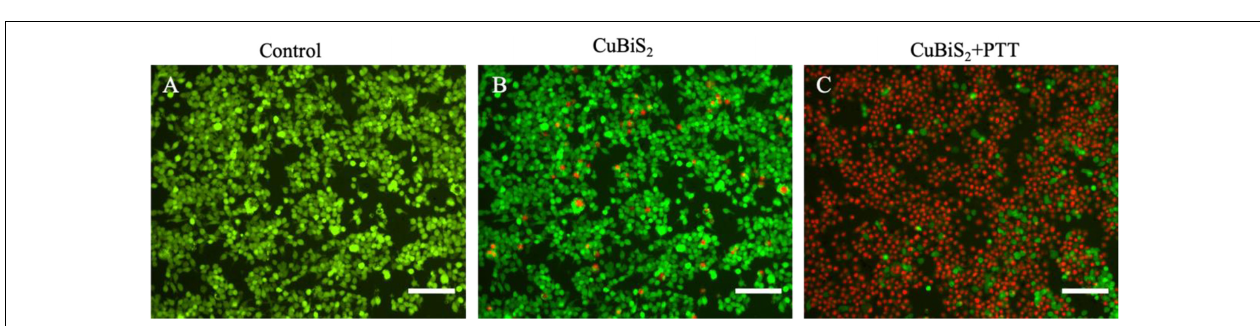
FIGURE 4 | Photothermal effect of CuBiS 2 NPs on macrophages by Calcein AM/PI and flow cytometry. (A–C) Representative images of live (green) or dead (red) cells without or with CuBiS 2 NPs co-incubation (160 mg/mL), respectively. Scale Bar: 100 µ m.